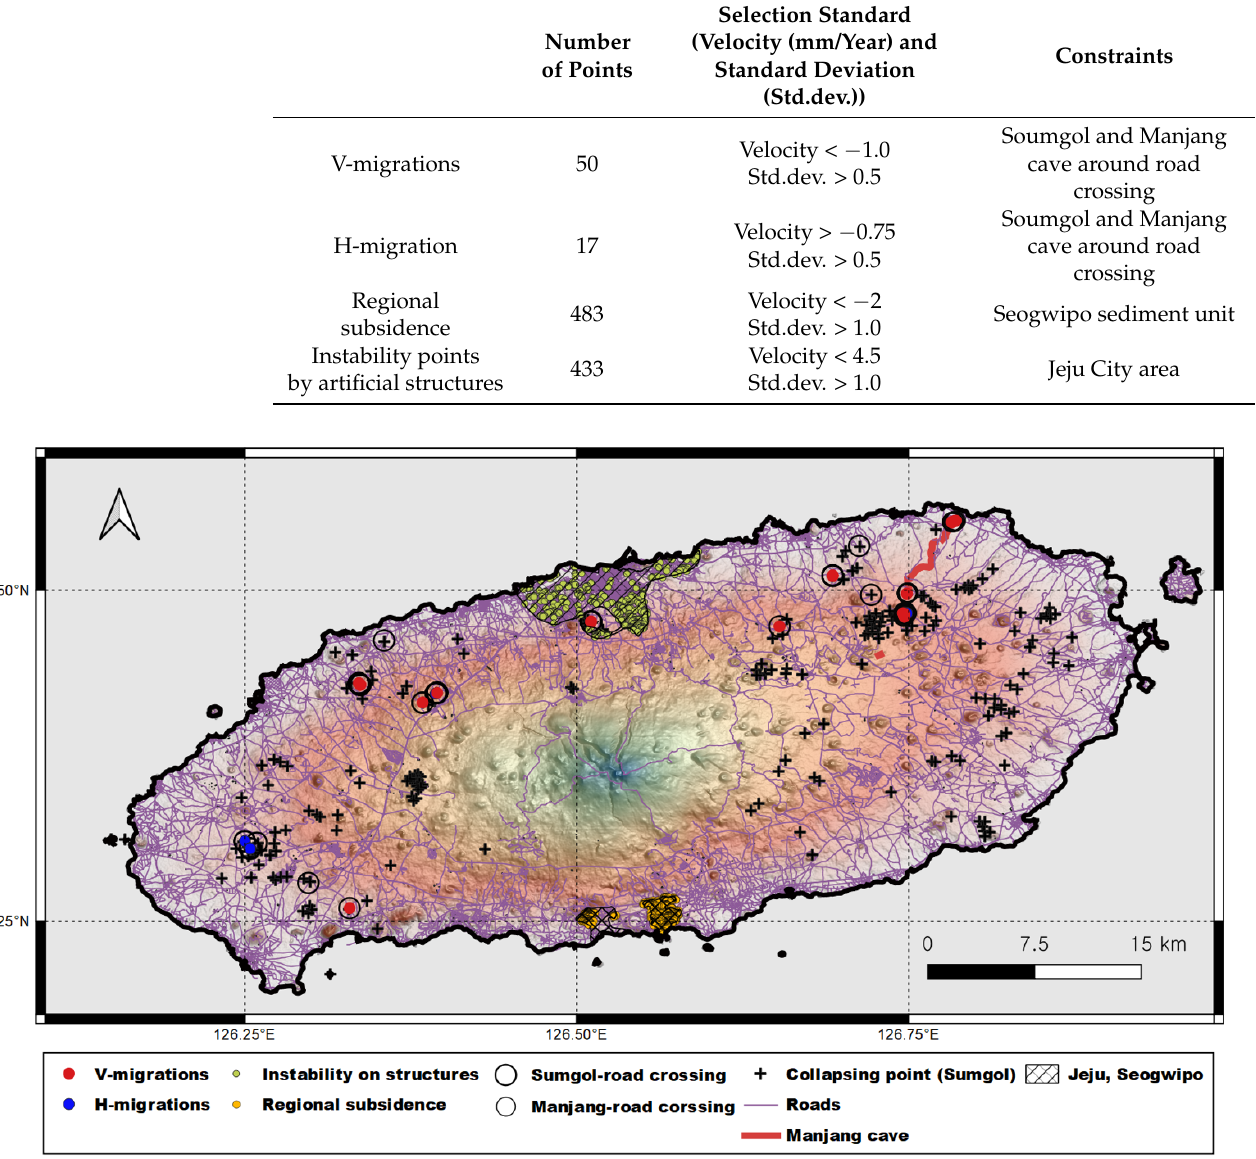
Table 2. The number and standard of training data.